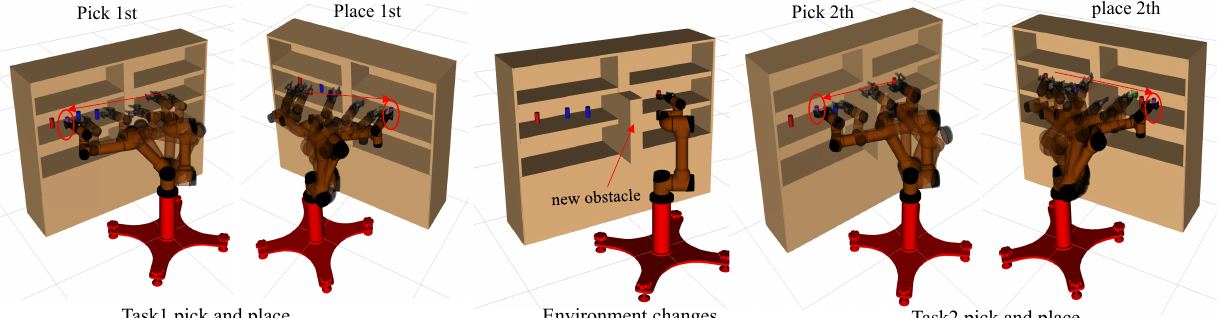
Figure 8. The composite images of the AUBO − i5 in shelf stacking task. These pictures show the robot executing a series of joint commands generated by LDG, picking up objects from the shelf and placing them on the other side. Although the roadmap in LDG algorithm is built for specific scenes, when the environment changes (the position of the operated object changes or new obstacles appear), the algorithm can still ensure the completion of subsequent tasks by querying candidate